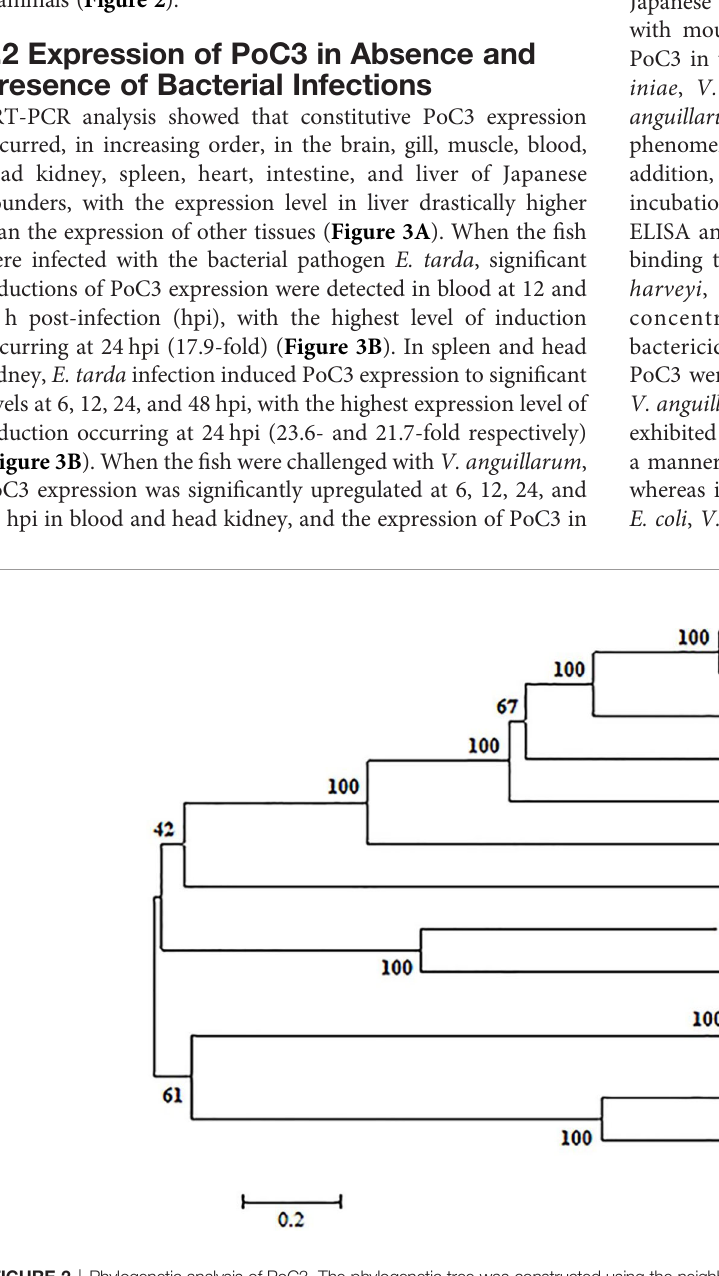
FIGURE 2 | Phylogenetic analysis of PoC3. The phylogenetic tree was constructed using the neighbor-joining method of MEGA-X based on the amino acid sequences from teleost and mammals. Data were analyzed using p-distance, with gaps removed by pairwise deletion. The topological stability of the tree was evaluated by 1000 bootstrap replications. The GenBank accession numbers of the phylogenetic sequences are as follows: Oryzias latipes -2, NP_001098553.1; Miichthys miiuy , AFC89899.1; Paralichthys olivaceus , BAA88901.1; Anarhichas minor , CAC29154.1; Oryzias latipes -1, NP_001098552.1; Larimichthys crocea , AHZ41228.1; Danio rerio , NP_001032313.2; Cyprinus carpio -H1, BAA36619.1; Cyprinus carpio- H2, BAA36620.1; Homo sapiens , NP_000055.2; Rattus norvegicus , NP_058690.2; Bos taurus , NP_001035559.2; Sus scrofa ,